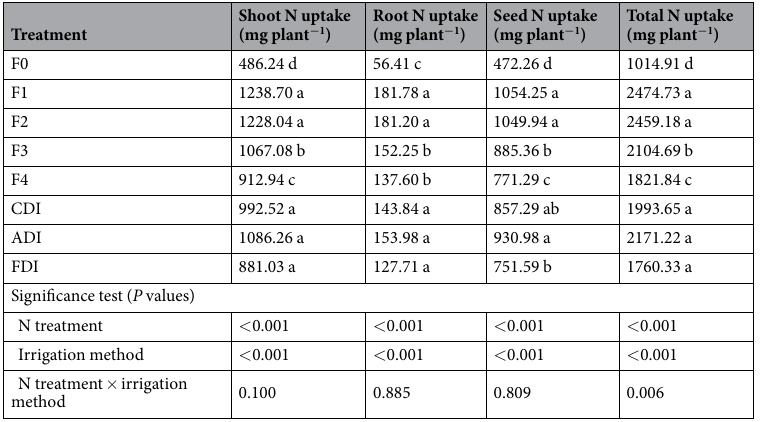
Table 4. Mean N uptake of sweet-waxy maize for different irrigation methods and N treatments. Analysis of variance (ANOVA) P values were shown ( P < 0.05, significance; P > 0.05, no significance). Different small letters in the same column are significantly different for various N treatments or irrigation methods ( P < 0.05), and the same letters are not markedly different for various N treatments or irrigation methods ( P > 0.05).